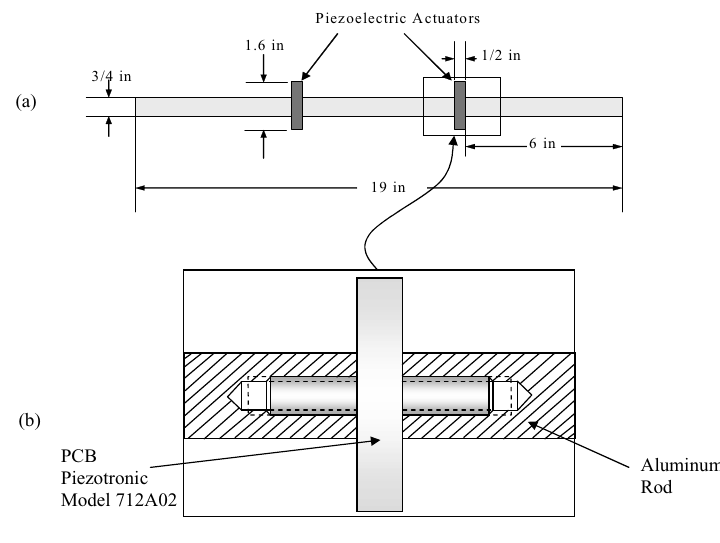
Fig. 7. Geometrical parameters of the hybrid rod.